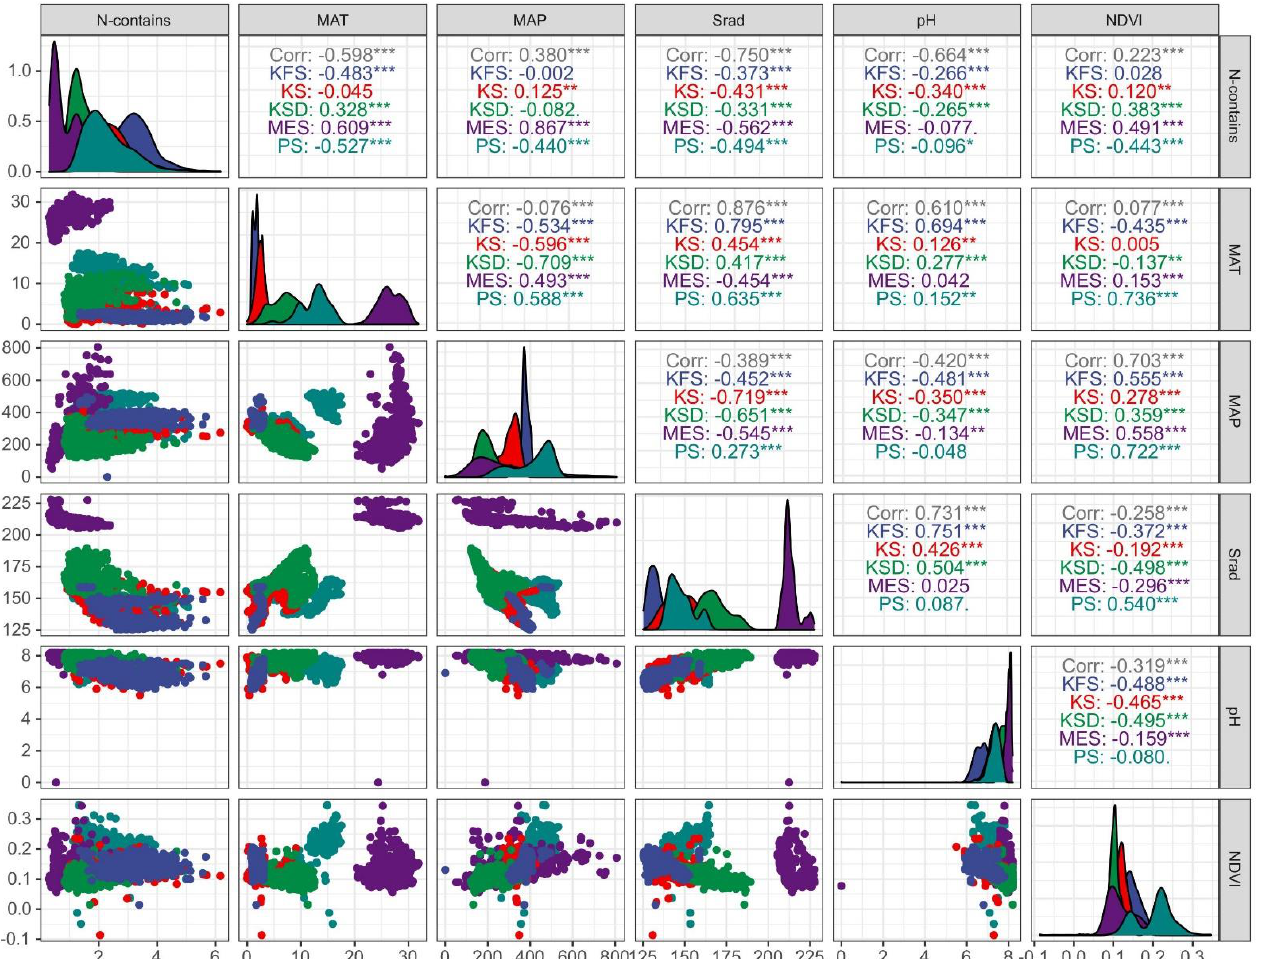
Figure 3. The distribution of soil nitrogen content and the values associated with each contributing factor in various grasslands. Note: PS: Pontic Steppe; MES: Middle East Steppe; KS: Kazakh Steppe; KSD: Kazakh Semi-Desert Steppe; KFS: Kazakh Forest Steppe; MAT: mean annual temperature; MAP: mean annual precipitation; Srad: solar radiation; pH: soil pH; NDVI: Normalized Difference Vegetation Index.***: Extremely significant correlation; **:significant correlation